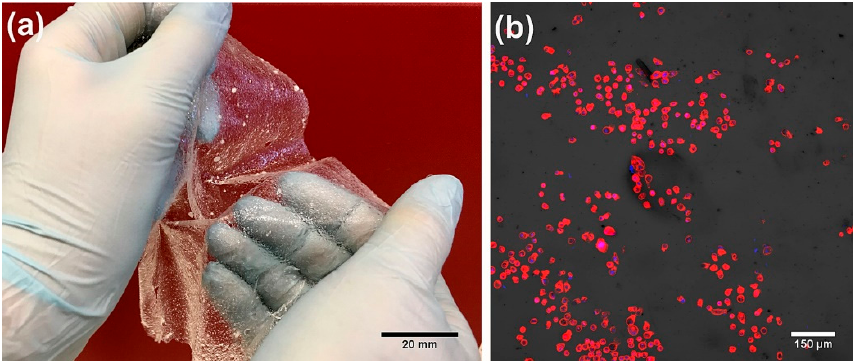
Figure 4. Epidermal skin graft: ( a ) image presenting a thin chitosan/agarose membrane